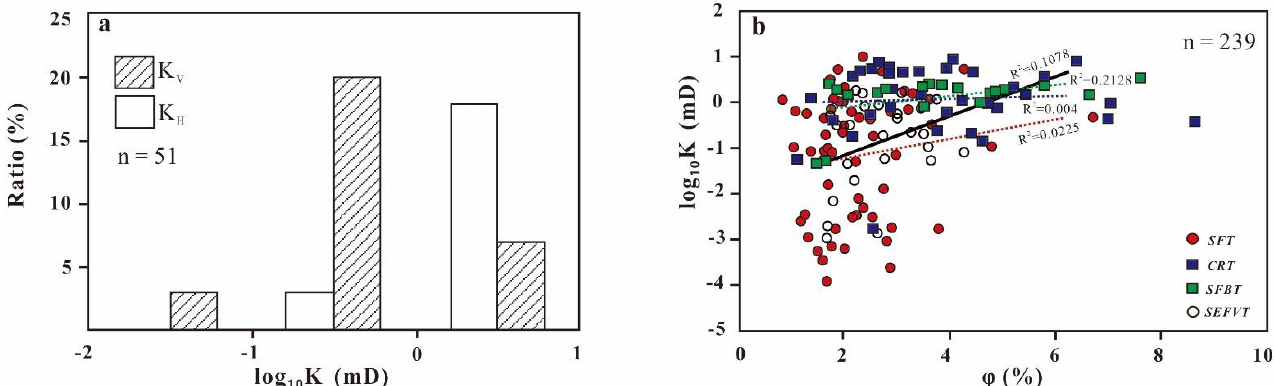
Figure 6. Features of permeability of void space types (SFT: solutionfilling type; CRT: cement-reducing type; SFBT: solution-filling breccia type; SEFVT: solution-enlarging fractures and vugs type): ( a ) the vertical and horizontal permeability of cement-reducing type (CRT); ( b ) correlation between porosity and the logarithm of permeability.